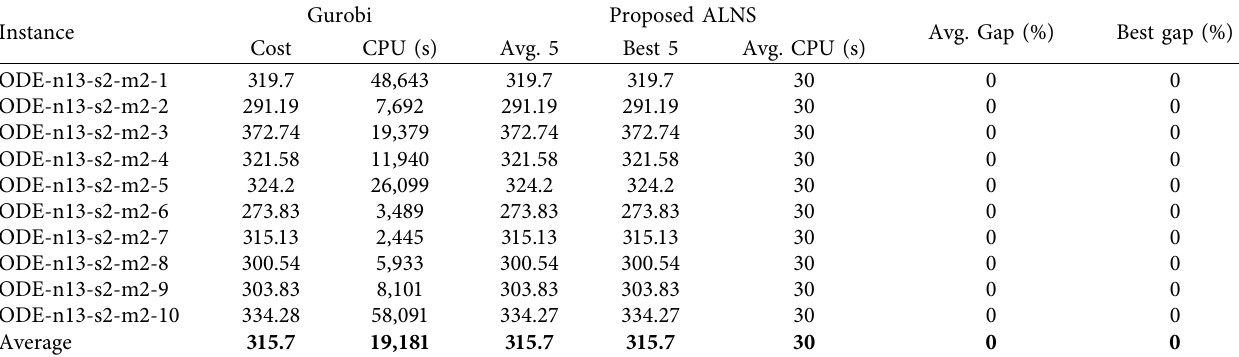
Table 7: Comparison between Gurobi and the proposed ALNS for solving Set 1 instances of 2EVRP-TN-OD. Gurobi Proposed ALNS Instance